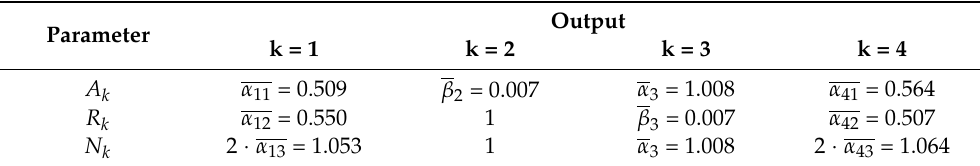
Table 7. The calibration parameters calculated for a set of temperatures of 290 and 500 K applied to both inputs normalized to α 2 = 4.750 × 10 − 9 W/K. Parameter